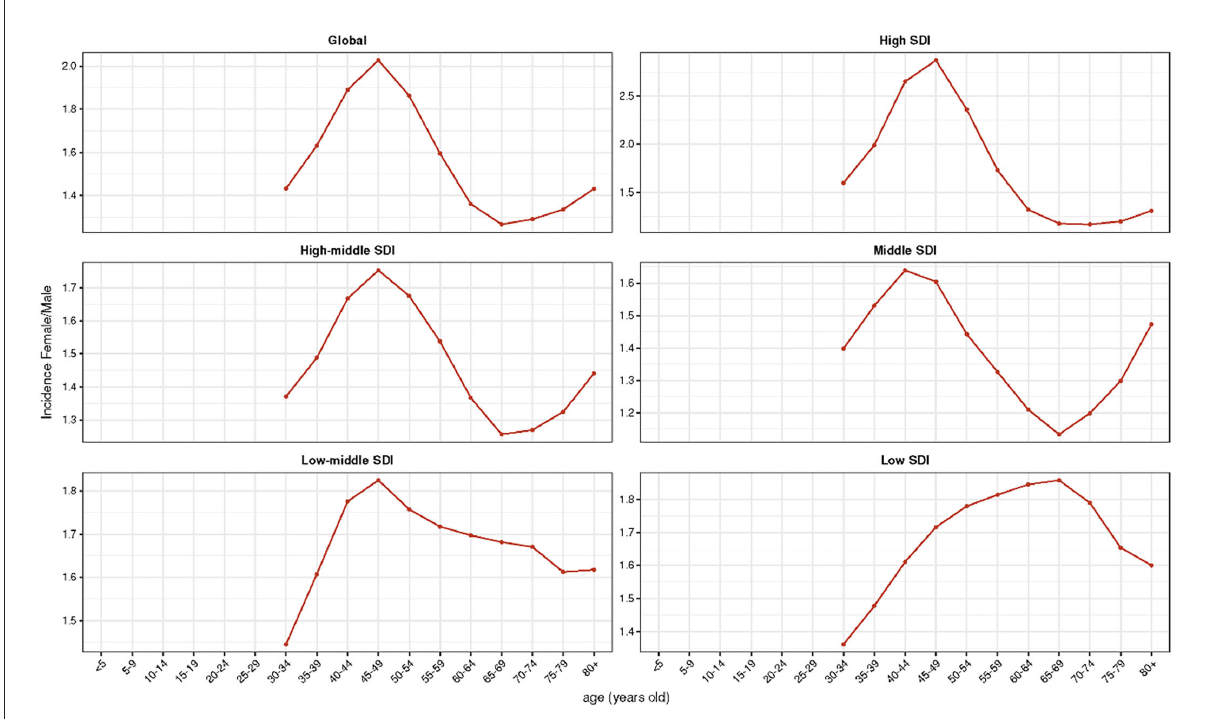
FIGURE2 Female-to-male ratio of the incidence among different age groups and different socio-demographic index (SDI) quintiles in 2019.